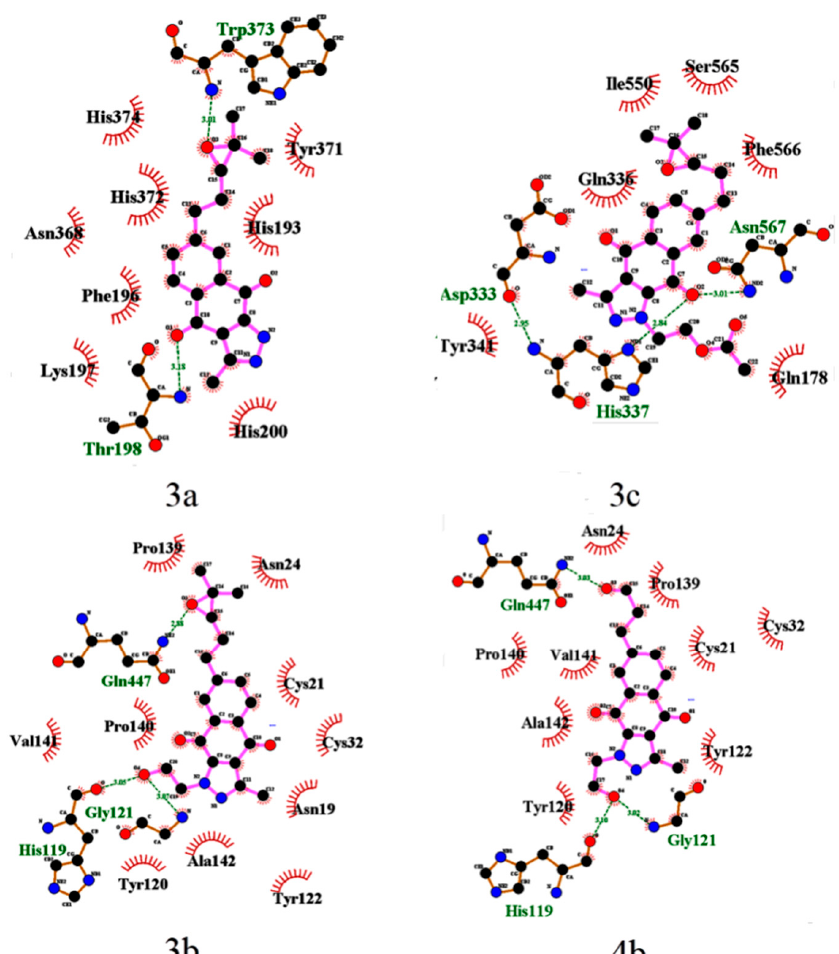
Figure 2. LigPlot + 2D-maps of hydrogen-bond interaction patterns and hydrophobic contacts between some BIZQs and the main-chain or side-chain elements of COX-2 protein. The amino acids responsible for hydrogen bonds and hydrophobic interactions are represented by three-letter codes in green and black, respectively. Carbon, oxygen, and nitrogen atoms are represented by filled black, red, and blue circles, respectively.